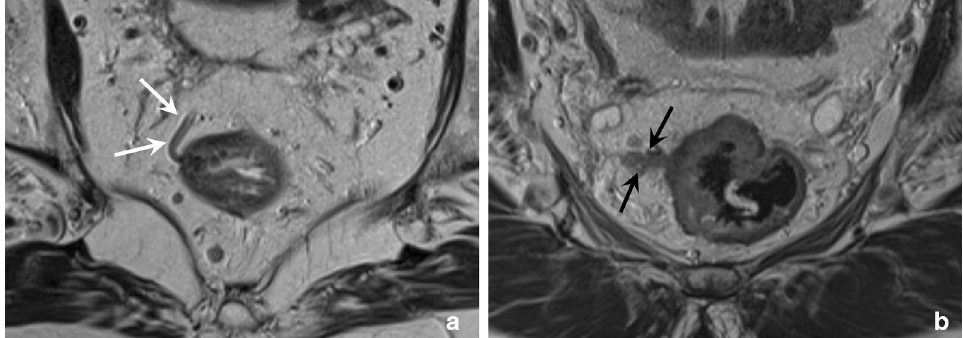
Fig. 11 Axial T2‑weighted images of two rectal cancer patients; a 63‑year‑old male patient with a cT1‑2 rectal tumour ( a ; tumour not shown) an another 83‑year‑old female patient with a cT3cd tumour ( b ). The image in A is a cross section just above the level of the tumour in the rectal wall and shows a small vessel radiating outwards from the muscularis propria into the perirectal fat (white arrows). The vessel has a normal contour and low T2 signal; there are no signs of EMVI. The image in b shows a semicircular tumour that involves the rectal wall from 7 till 1 o’clock. The intermediate signal of the tumour extends into the adjacent vessels. The vessels is expanded, and the vessel contour is disrupted. These are all signs indicative of